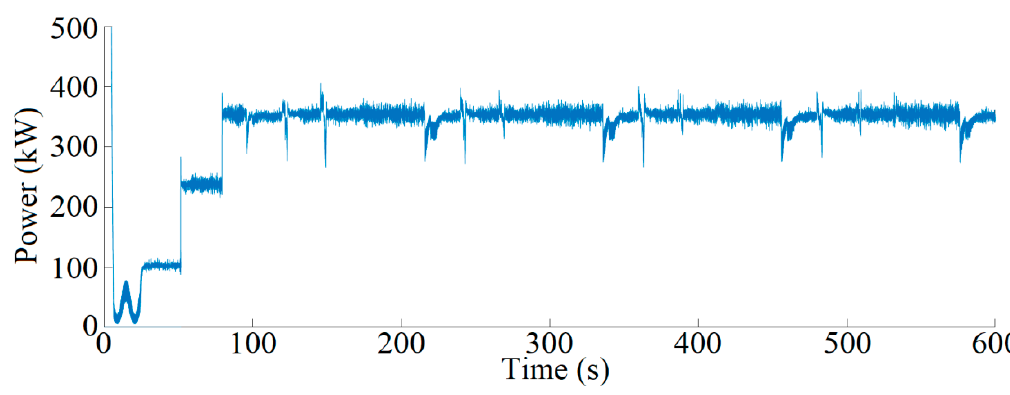
Figure 7. Generated active power of the farm at the main bus.